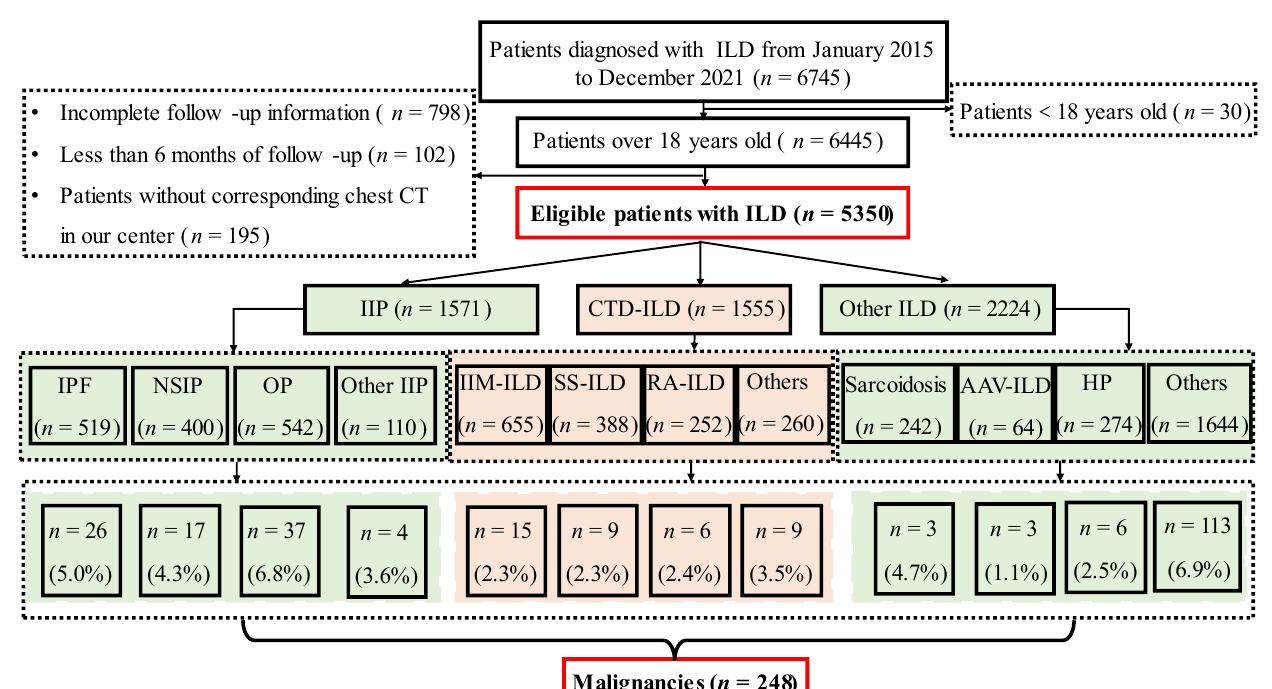
Figure 1. Study Design Flow Chart. ILD, interstitial lung disease; IPF, idiopathic pulmonary fibrosis; NSIP, nonspecific interstitial pneumonia; OP, organizing pneumonia; CTD-ILD, connective tissue disease-associated ILD; HP, hypersensitivity pneumonitis; AAV, anti-neutrophil cytoplasmic antibodies-associated vasculitis; IIM, idiopathic inflammatory myopathies; SS, Sjögren’s syndrome ; RA, rheumatoid arthritis.